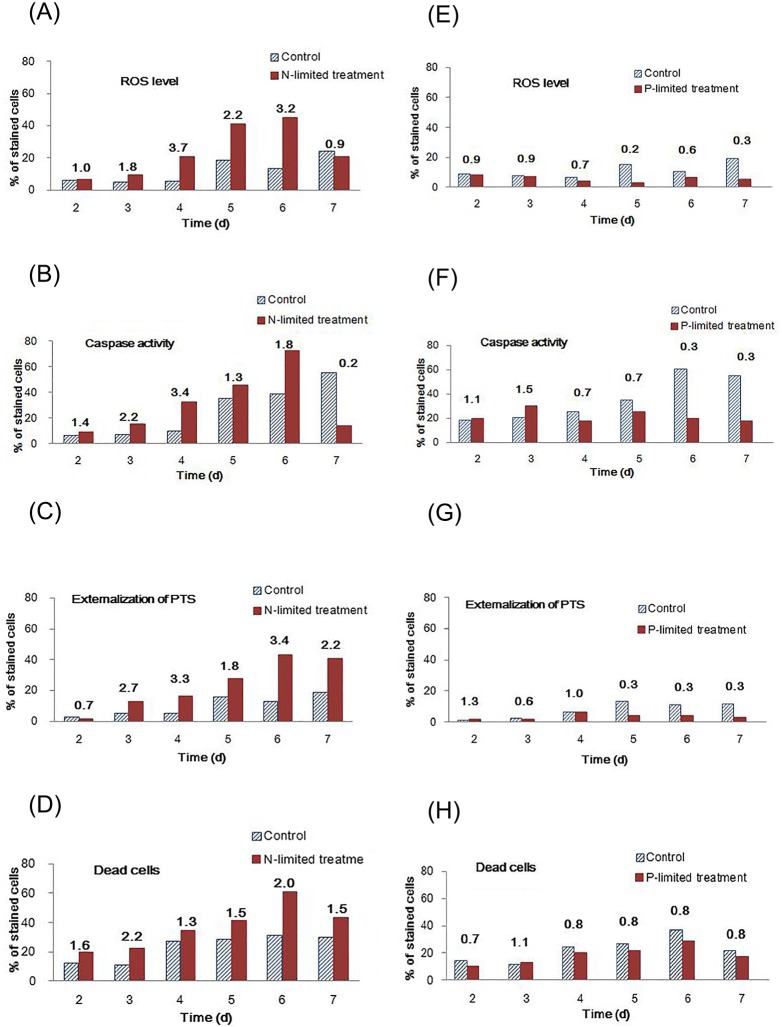
Examination of ROS production, biochemical characteristics of programmed cell death (PCD), and cell death in T. pseudonana cells grown under different conditions.In vivo detection of the ROS level (CM-H2DCFDA; A, E), caspase activity (CaspACE; B, F), externalization of phosphatidylserine (Annexin V; C, G), and dead cells (SYTOX; D, H) in T. pseudonana using flow cytometry. Cells were grown in nutrient replete (control), N-limited (A-D), or P-limited (E-H) media on days 2–7. Numbers above columns represent ratios of positive cells under limited: control conditions.